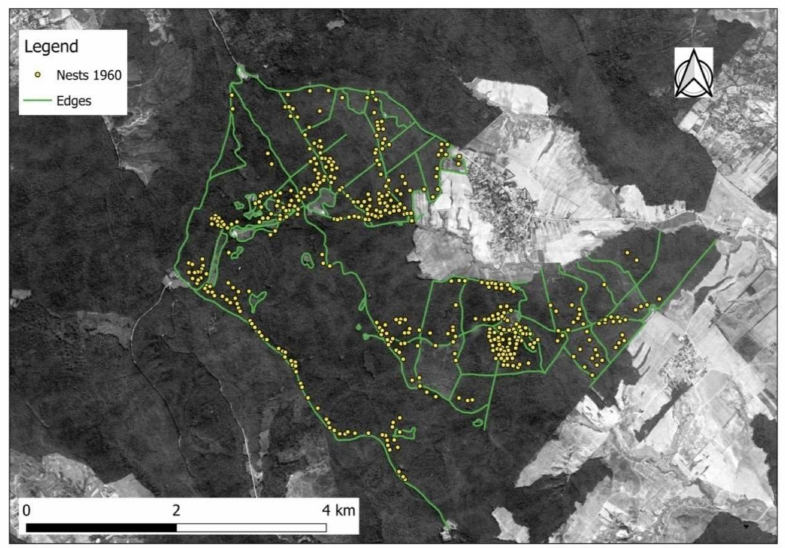
Figure 3. Position of forest edges identified on the 1964 Corona spy satellite image and distribuTable 1960.